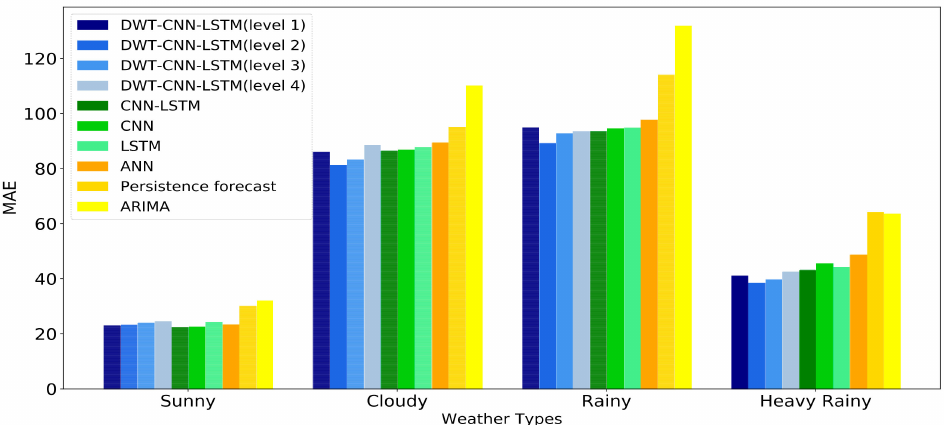
Figure 11. The MAE of different forecasting models for sunny, cloudy, rainy and heavy rainy days using the dataset of Elizabeth City State University.